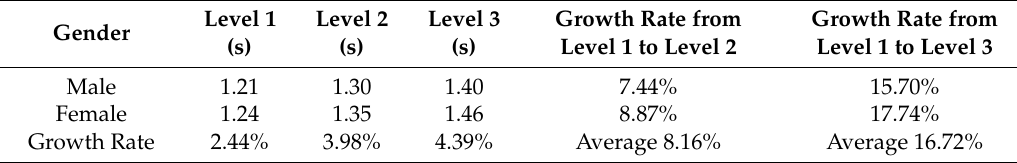
Figure 3. The relationship between reaction time, age, gender and mental fatigue levels. Table 6. The average reaction time of different mental levels.